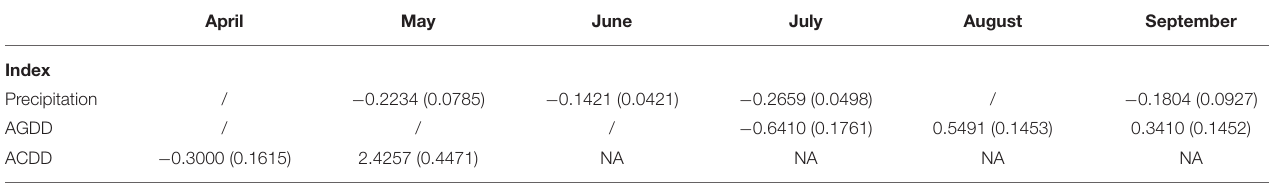
TABLE 5 | The simulation results are based on Model III-optimal.